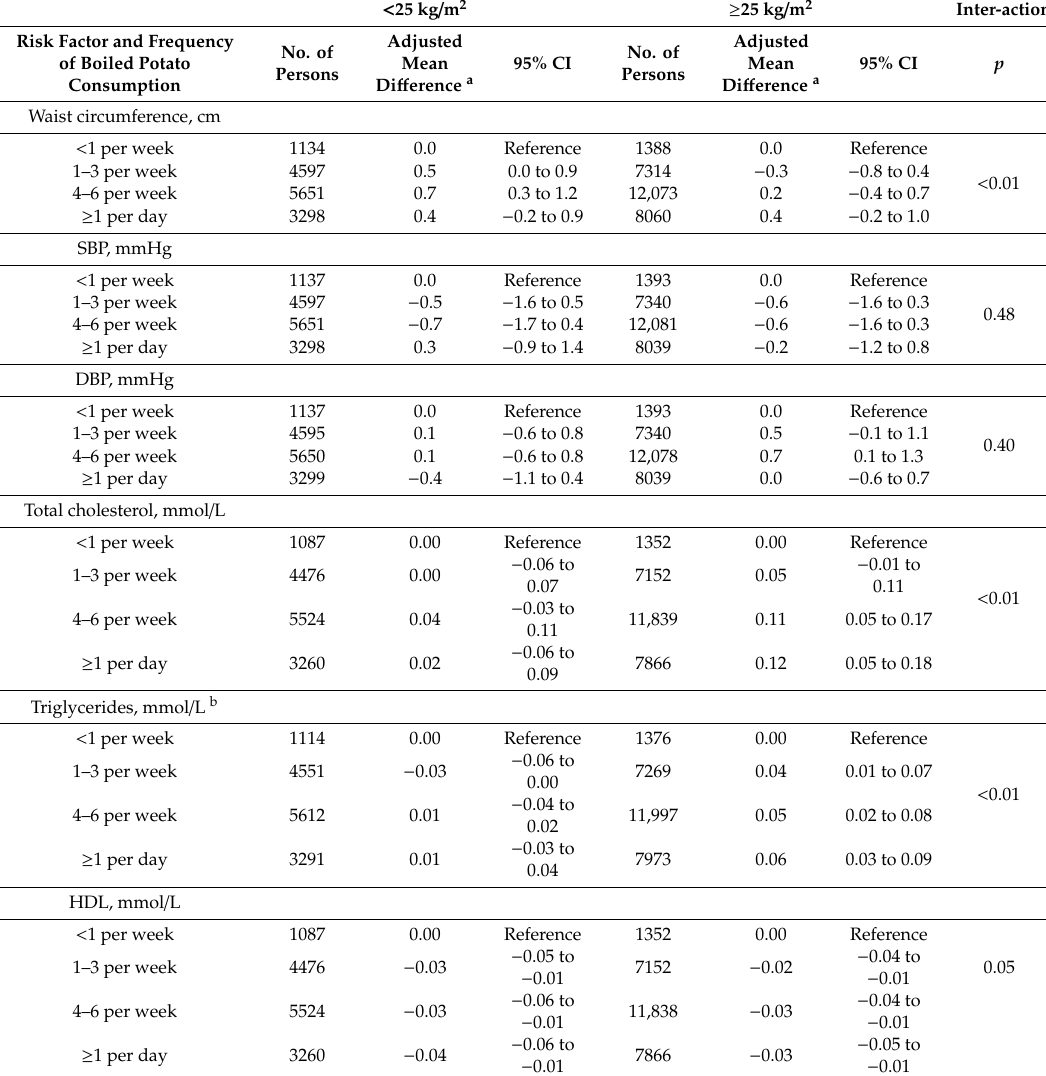
Table 4. Mean di ff erence in cardiovascular disease risk factors according to potato consumption, stratified by body mass index